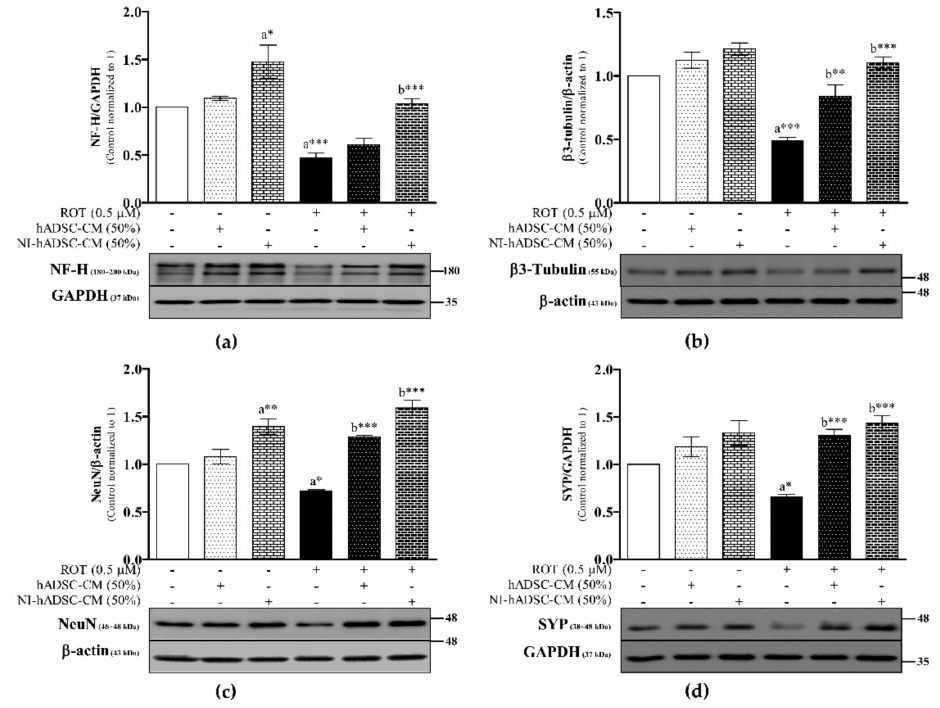
Figure 5. Effects of NI-hADSC-CM against ROT on protein expression of neuronal markers. SH-SY5Y cells were seeded at a density of 5 × 10 4 cells/mL in DMEM containing 1% FBS and used for experiments after overnight incubation. Cells in the absence or presence of ROT (0.5 µ M) for 48 h were treated with hADSC-CM (50%) or NI-hADSC-CM (50%) during the last 24 h, and the expression levels of NF-H ( a ), β 3-tubulin ( b ), NeuN ( c ), SYP ( d ), and GAPDH or β -actin were analyzed by Western blotting. Images are representative of three independent experiments. Data are presented as mean ± SEM of three independent experiments. Statistical analysis was performed using one-way analysis of variance (ANOVA) followed by Tukey’s post hoc test. Statistical significance: a—compared with control; b—compared with ROT; * p < 0.05, ** p < 0.01, and *** p <